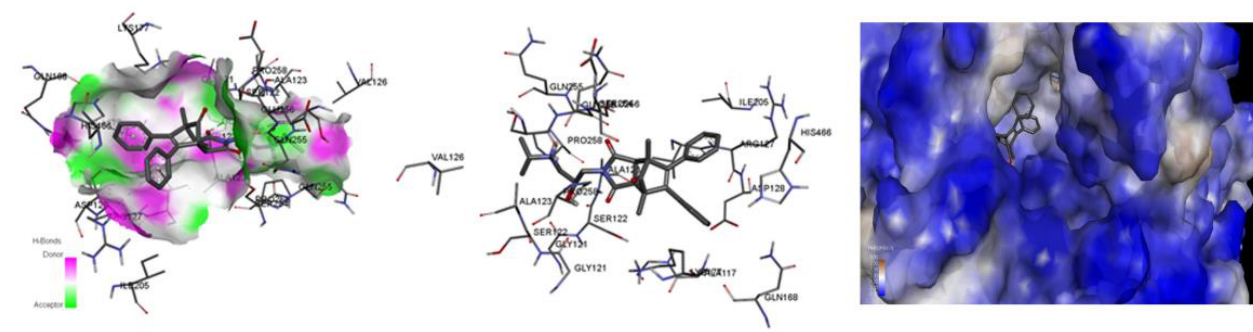
Figure 6. Bioactive conformation of compound III.